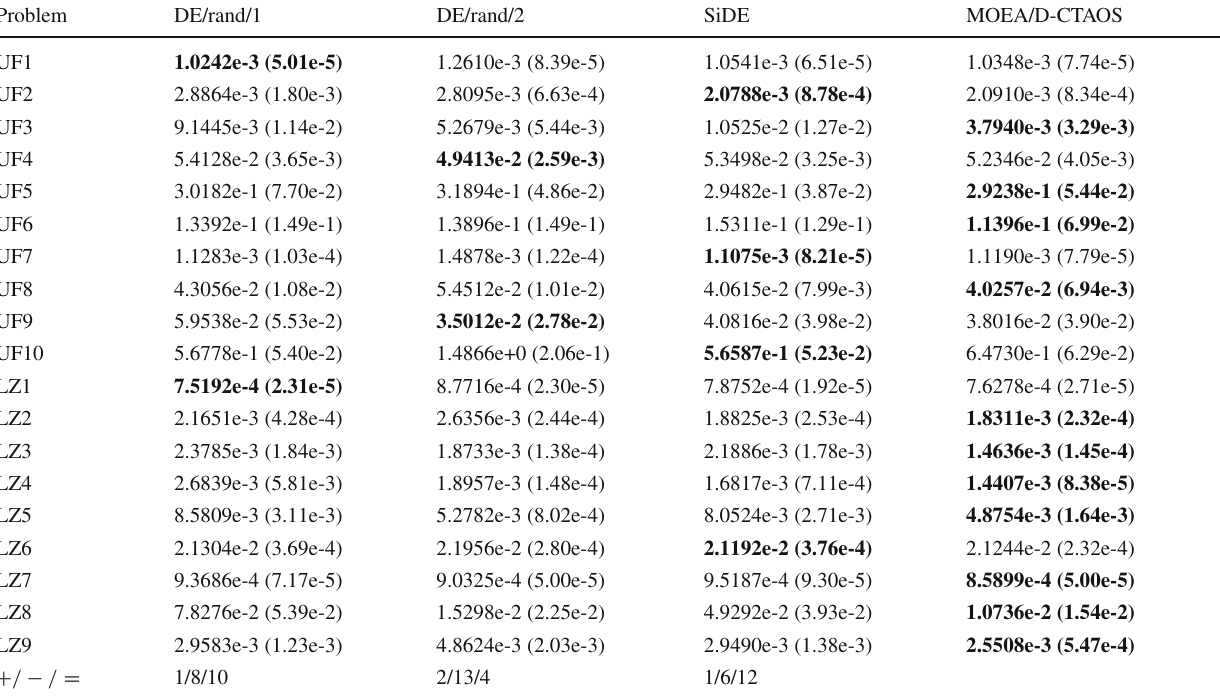
The best entries are highlighted in boldface according to the IGD or HV value Table 6 Average and standard deviation IGD values obtained by four versions of MOEA/D-CTAOS on each benchmark (30 runs)